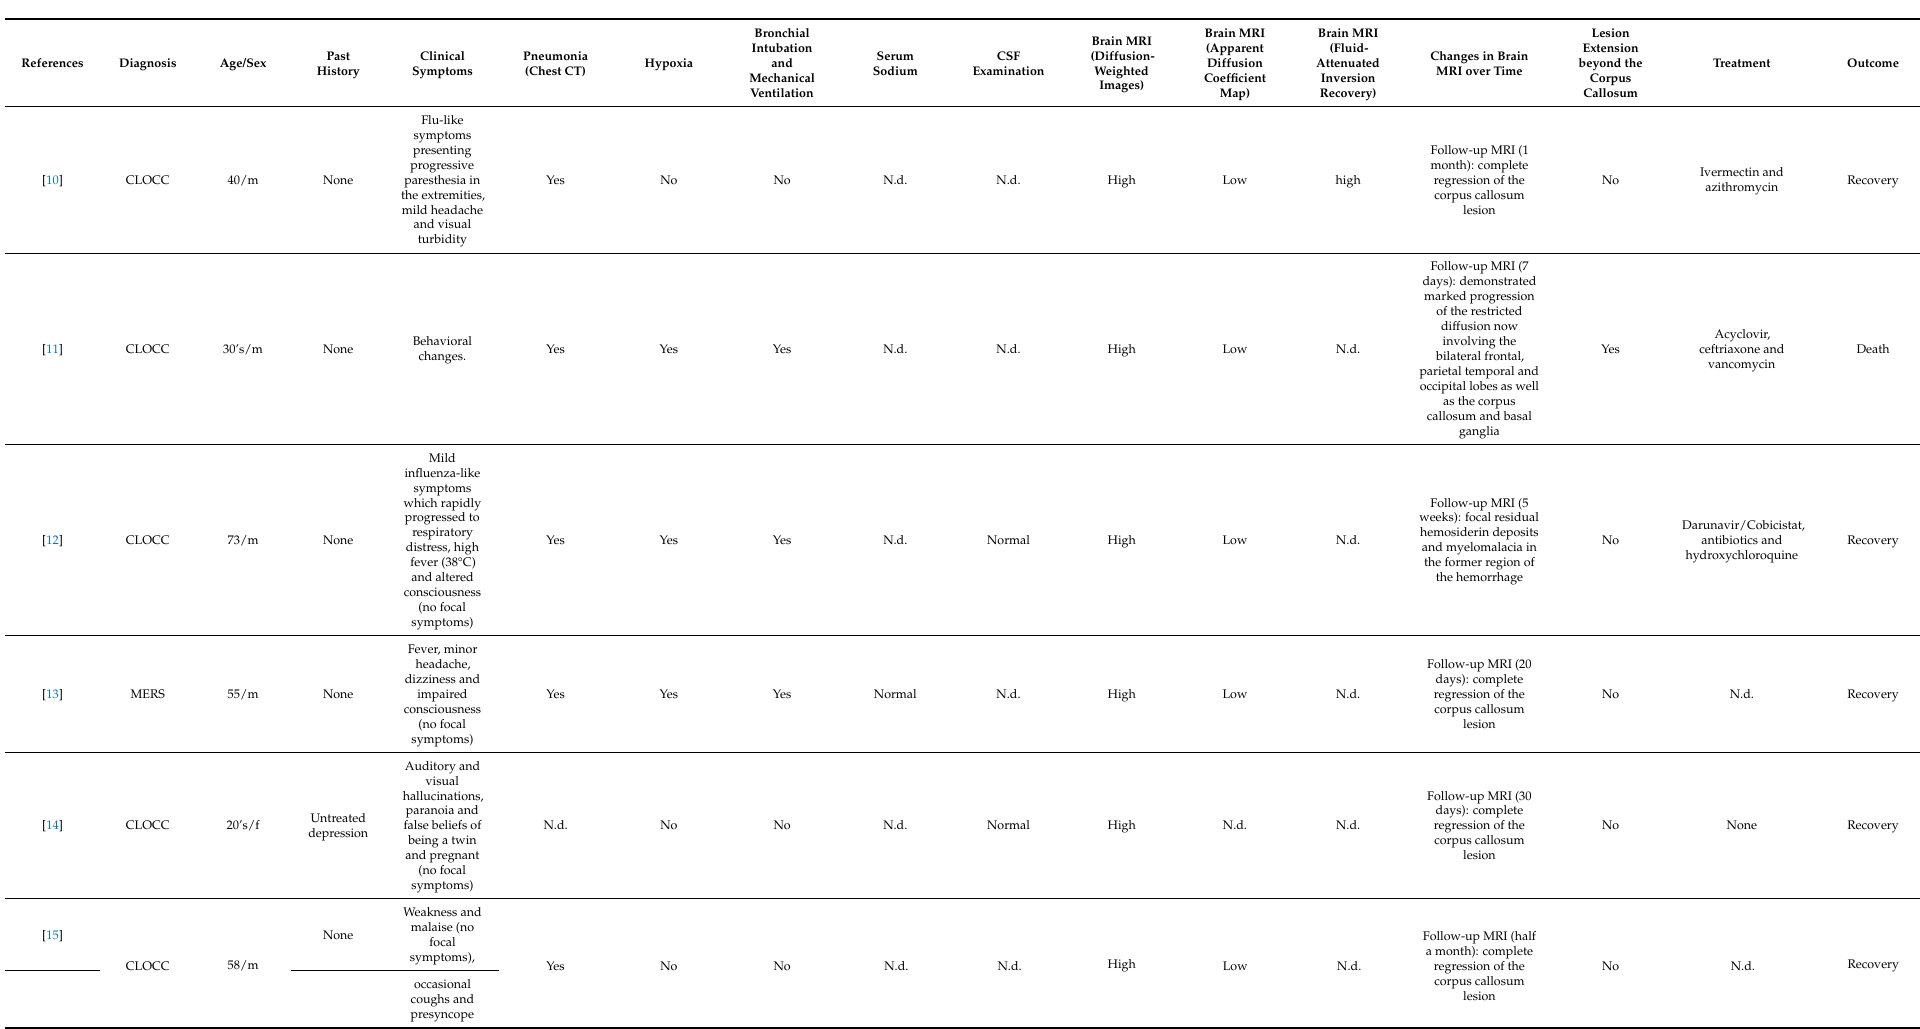
Table 1. Reported cases of MERS or CLOCC with